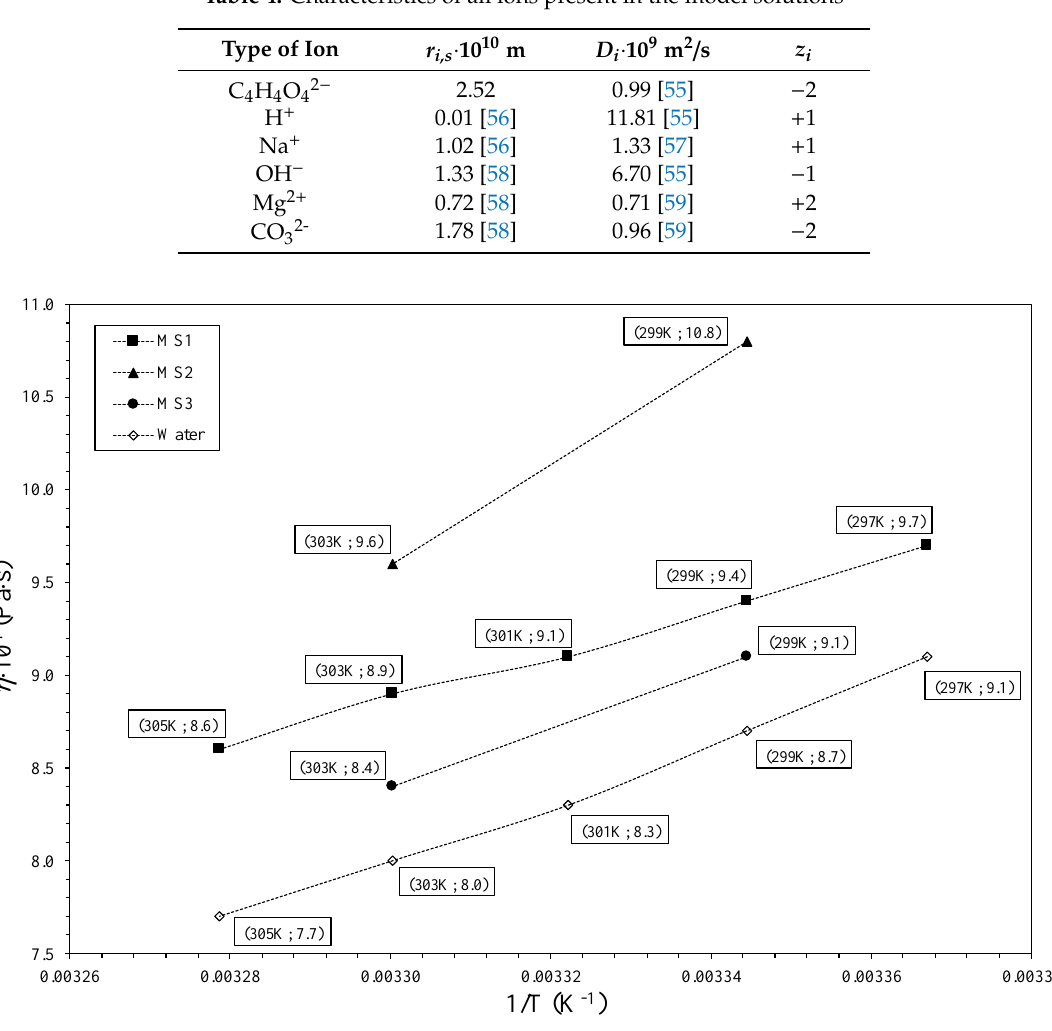
Figure 2. Experimental viscosity values of model solutions (MS1, MS2, MS3) and reference water viscosity in relation to temperature. Data in labels are ordered according to temperature expressed in Kelvin and value of viscosity.